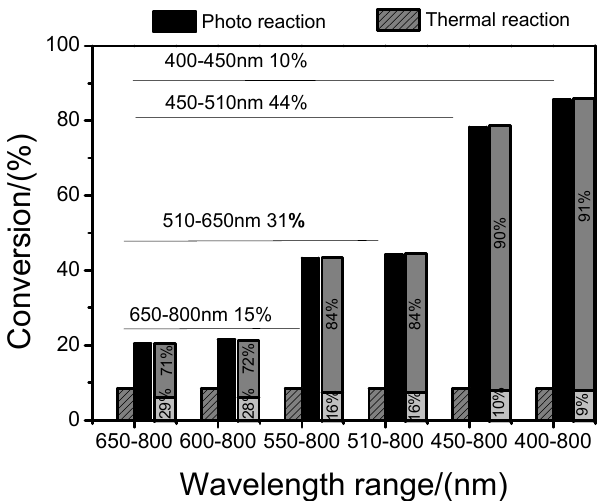
Figure 6. Effect of the light wavelength on the esterification of benzaldehyde using 71 wt% Ag 3 PO 4 /Ag/Bi 2 O 2 CO 3 .